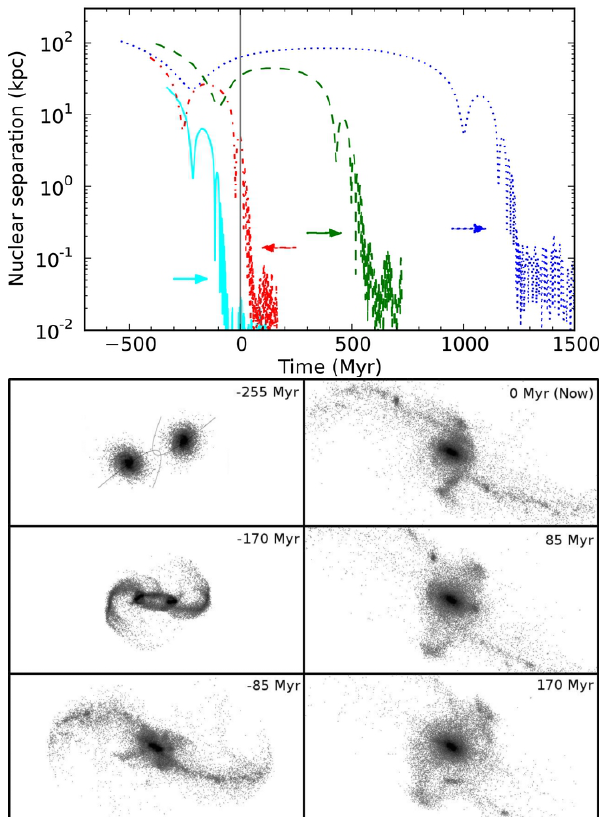
Figure 16. ( Top ) Nuclear separation as a function of time for four merging systems (from left to right: NGC 2623, Antennae, The Mice, and NGC 5257/8) as determined from Identikit [263] dynamical modeling of H I and optical imaging. The vertical line at the time of zero represents the current viewing time. Colored arrows mark the corresponding smoothing length in kpc for each system, below which the spatial resolution of the simulations may not be reliable. ( Bottom ) Example snapshots of how LIRG NGC 2623 evolved as a function of time. The grey lines show the initial Keplerian orbits of the galaxies, and the times shown are relative to now. Figures adapted from Privon et al. [262]; © AAS, reproduced with